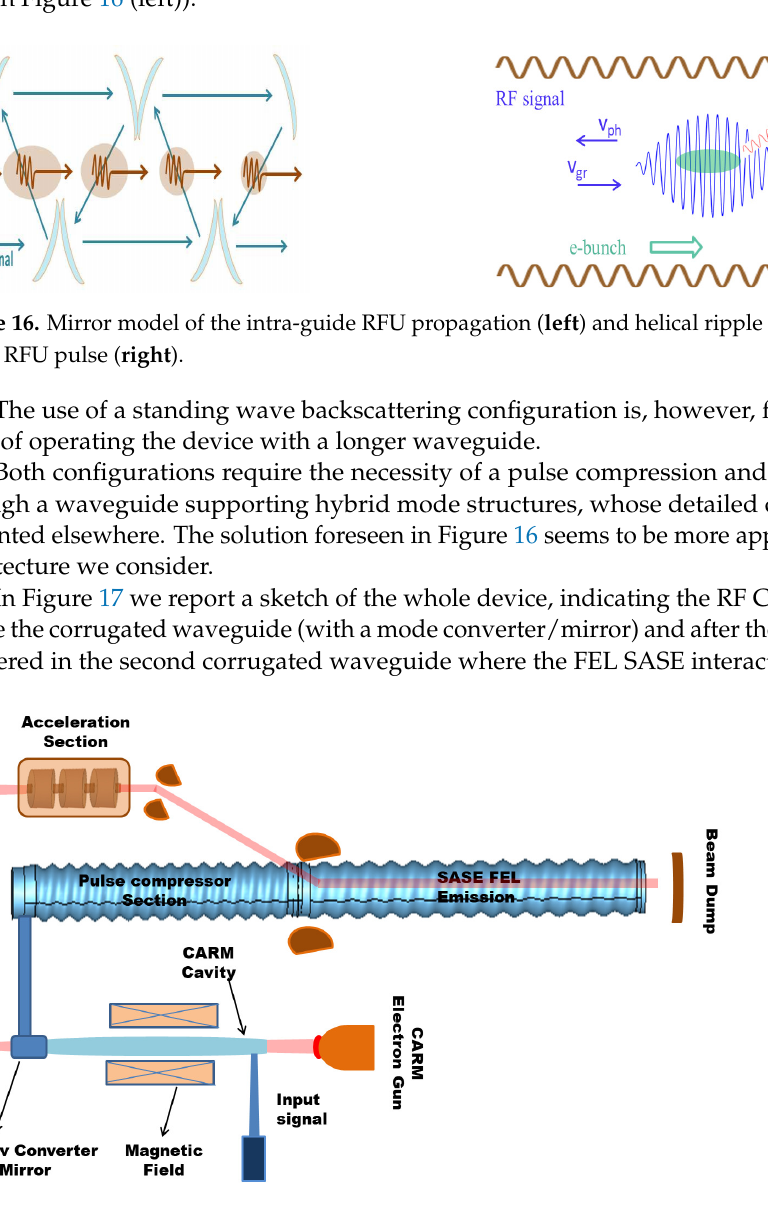
Figure 17. CARM-Undulator, SASE-FEL layout. Lower part: CARM generator and radiation transport system. Upper part: consecutive helical waveguides, the first acts as RF power compressor, the second, feeded with an external e-beam, realizes the SASE interaction